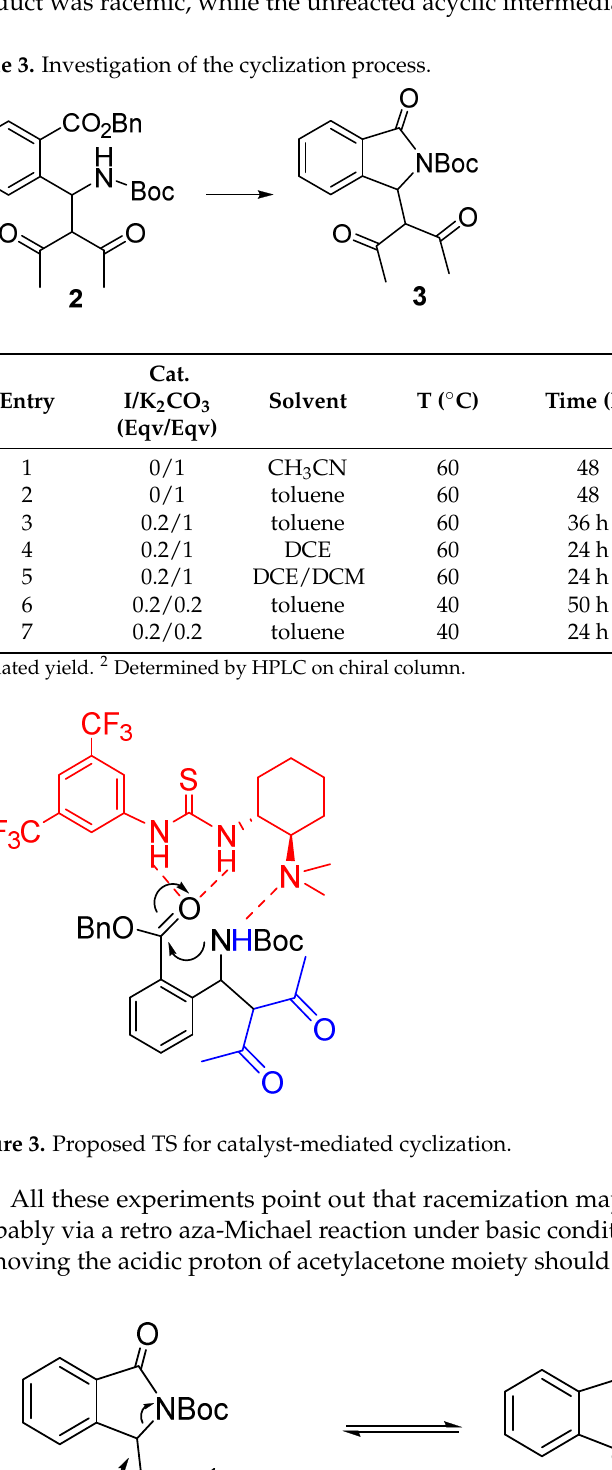
Table 3. Investigation of the cyclization process.